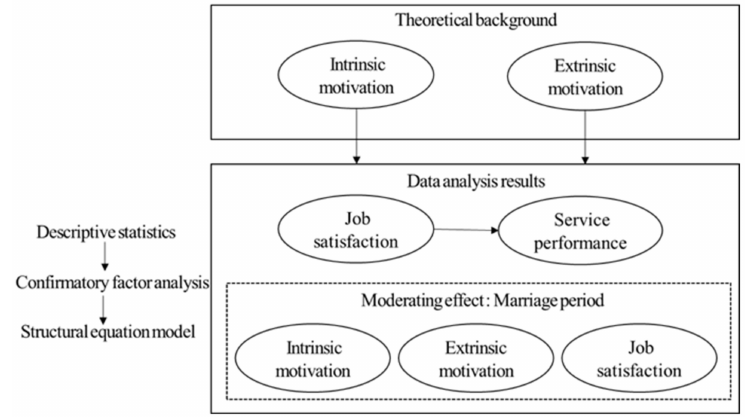
Figure 2. Research methodology.